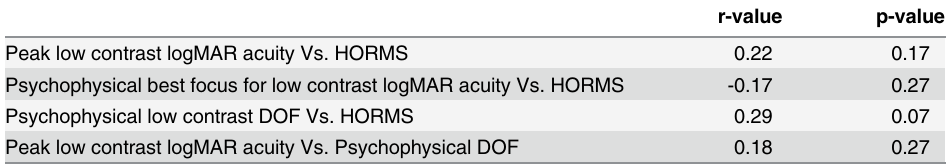
r-value p-value